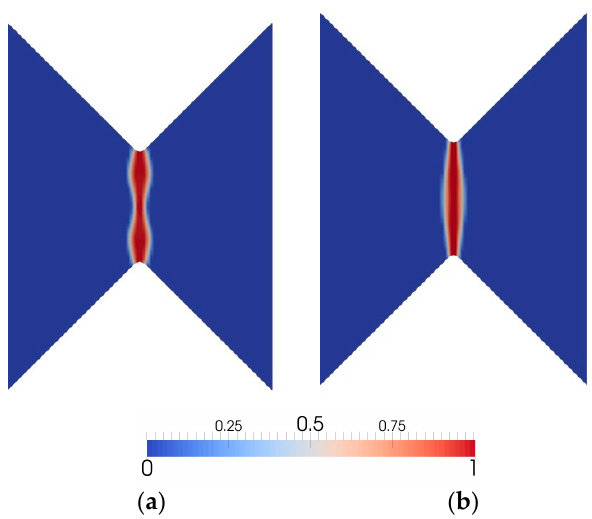
Figure 7. Final pattern of the phase field variable for the V ‐ notch sample at different loading rates; ( a ) rate ‐ independent ( b ) loading rate 0.03 mm/s.